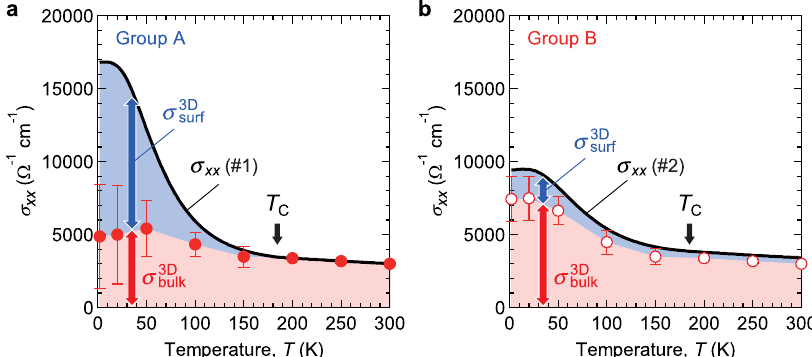
is estimated by the slope in t -dependent sheet conductance for bulk is plotted with the obtained conductance data for the representative bulk corresponds to the contribution of electrical conduction at the surface bulk . bulk